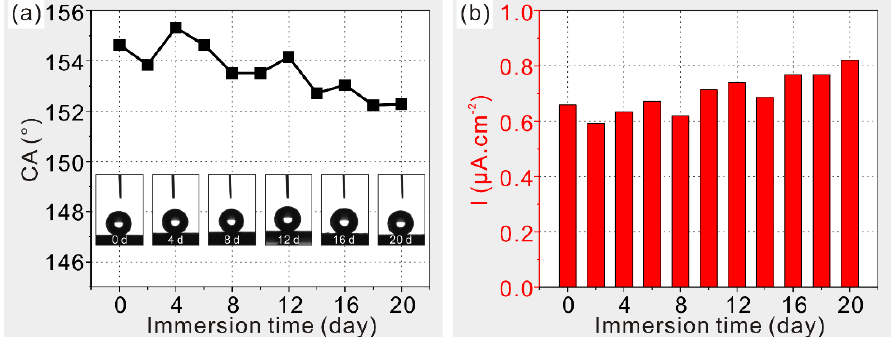
Figure 8. Effects of immersion time in seawater on ( a ) wettabilities and ( b ) corrosion resistances of the modified deposited sample.